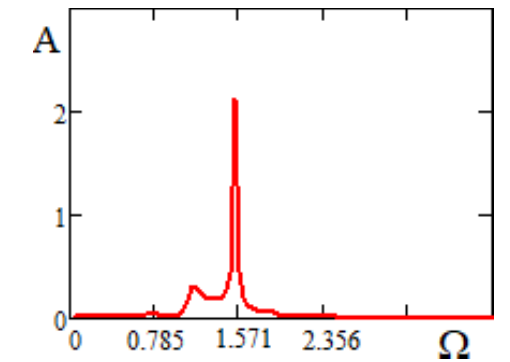
Figure 16. Dependence of the vibration phase α on the rotor speed (cid:127) with coefficient of non-linear stiffness of the support K 3 = 0 . 1 and at different values of the coefficient of linear viscous damping µ 1 .